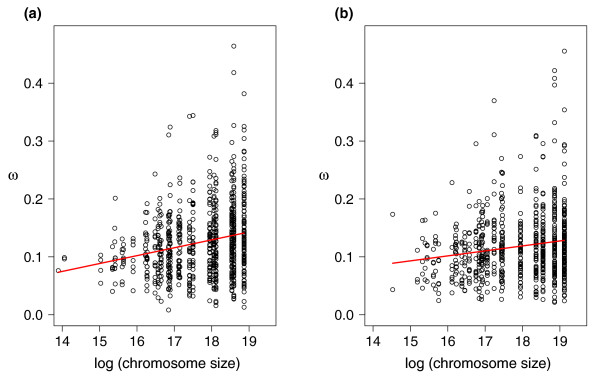
The relationship between ω estimated for 1-Mb intervals and chromosome size. (a) Zebra finch; (b) chicken.